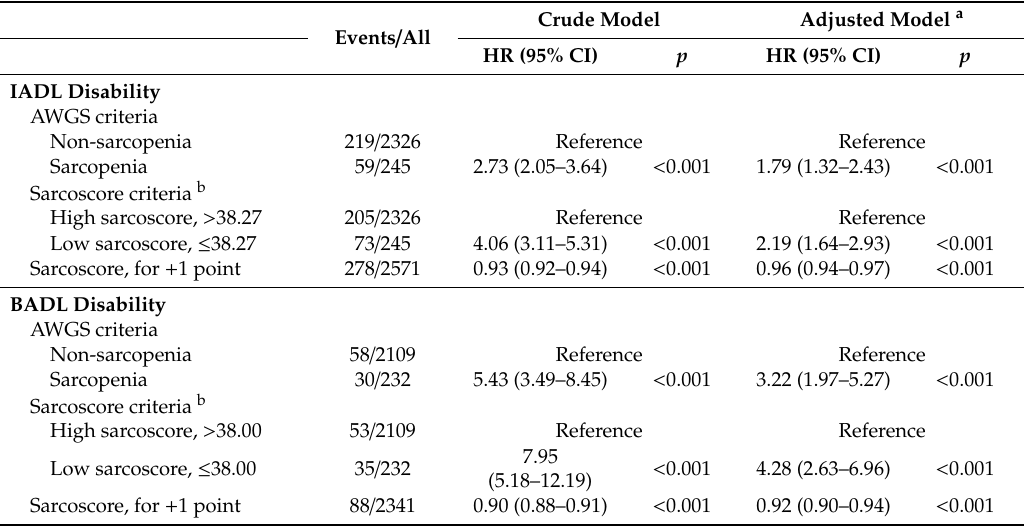
Table 2. Hazard ratios for the onset of instrumental activities of daily living, and basic activities of daily living disabilities according to the Asian Working Group for Sarcopenia and the sarcoscore criteria. Crude Model Adjusted Model a Events / All HR (95% CI) p HR (95% CI) p